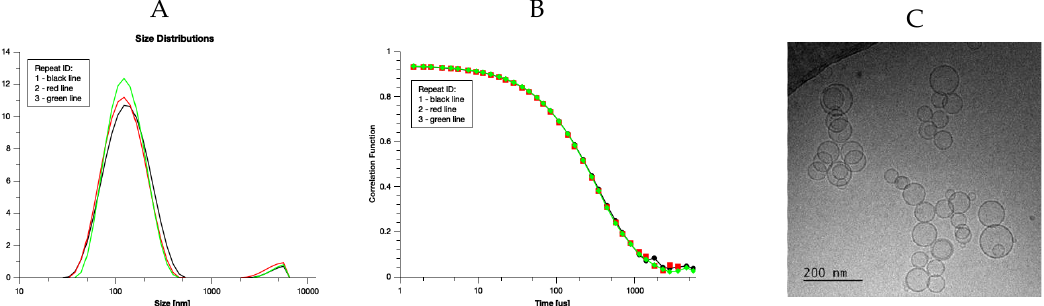
Figure 1. Size distribution of liposomes with vitamin D 3 . Panel ( A ) shows the liposome size distributions. Panel ( B ) presents correlation functions. The average diameter of liposomes and polydispersity index were equal to 117 nm and 0.23, respectively. Panel ( C ) presents the cryoTEM image of liposomes with vitamin D 3 .